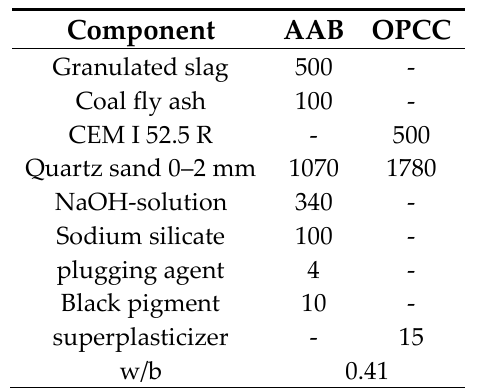
Table 1. Composition of AAB and OPCC in kg/m 3 .